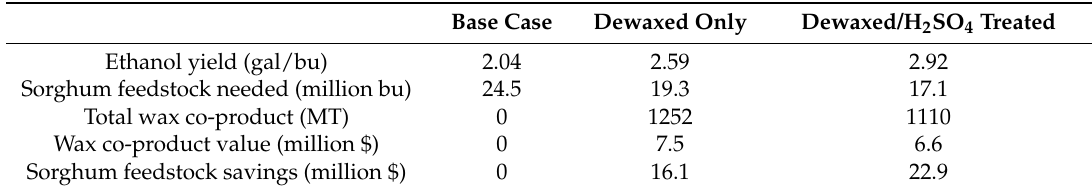
Table 7. Potential economic benefits of the integrated process for ethanol production using BRM sorghum grain as